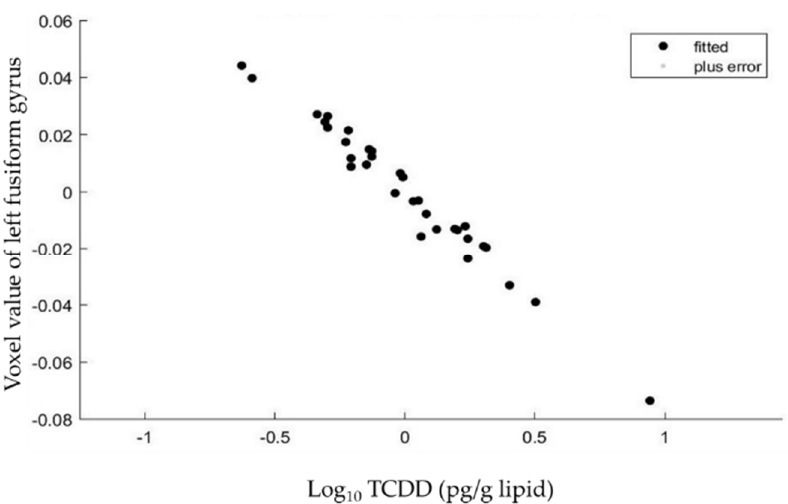
Figure 1. Relationships between the voxel values of the left fusiform gyrus at [ − 27 (x), 8 (y), − 47 (z)] and blood TCDD levels in the 32 subjects. There was a significant and inverse correlation between the two parameters after adjusting for total intracranial volume and age of the subjects.